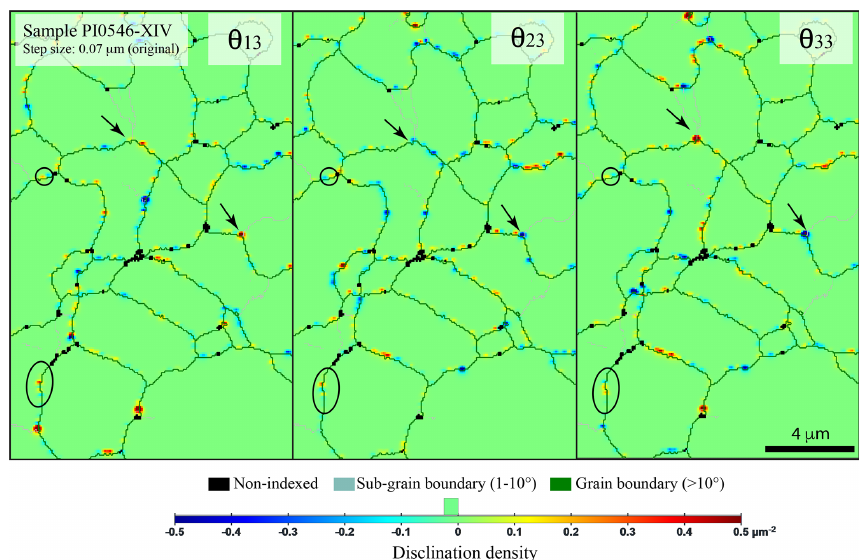
Figure 6. Representative distributions of the different disclinations ( θ 13 , θ 23 , and θ 33 ) reported in a sample deformed in torsion (PI0546- XIV). Circles indicate well-defined dipoles after smoothing. Arrows indicate dipoles at the junction between a sub-grain boundary and a grain boundary. The density scale is user-defined for this set of maps; the step size was 0.07µm, and the smoothing factor was